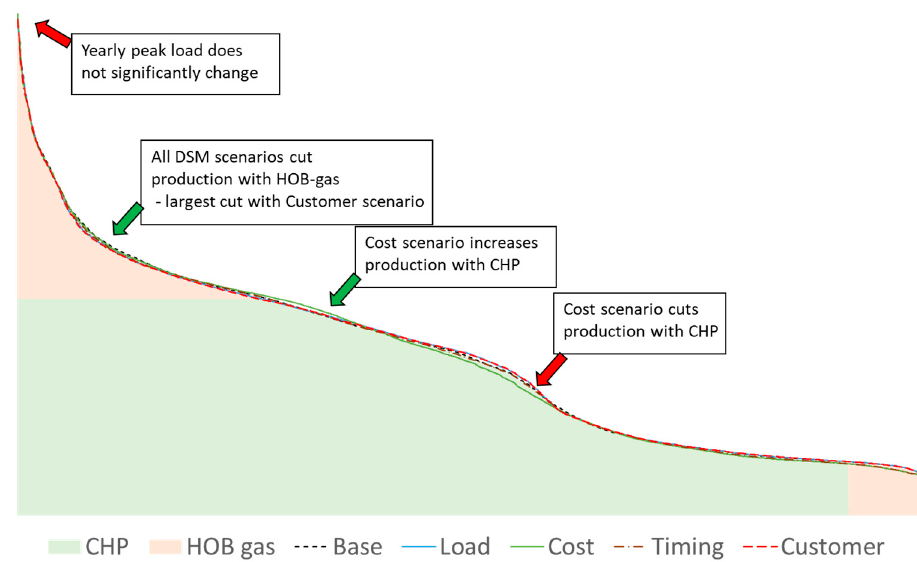
Figure 3. The changes in the heat load curve in the medium-sized DH system. Since changes in the annual demand curve across the different DSM scenarios are small and thus hard to see in the figure, the highlights are written in boxes. Table 3. The effect of the Cost scenario DSM implementation on separate customer segments in the medium-sized DH system. The first row in the table (Cost—All segments) represents the situation when all the customers are implementing DSM within the Cost scenario. The following rows represent the situation when only one customer segment implements DSM within the Cost scenario, and others follow the Base scenario. The results are compared to the Base